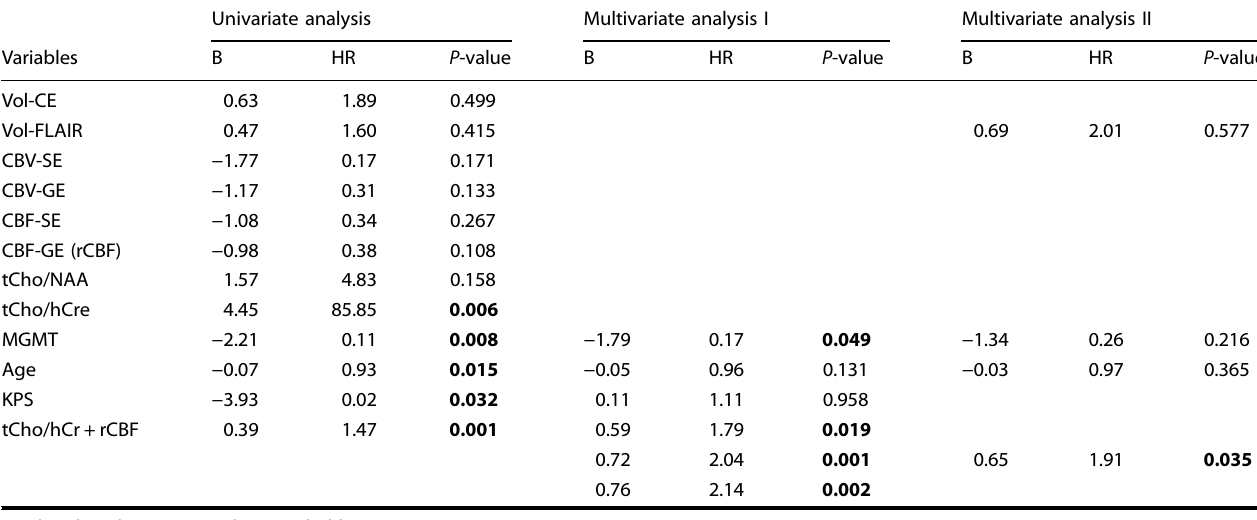
Table 1. Cox proportional hazard model of imaging, molecular, clinical, and demographic